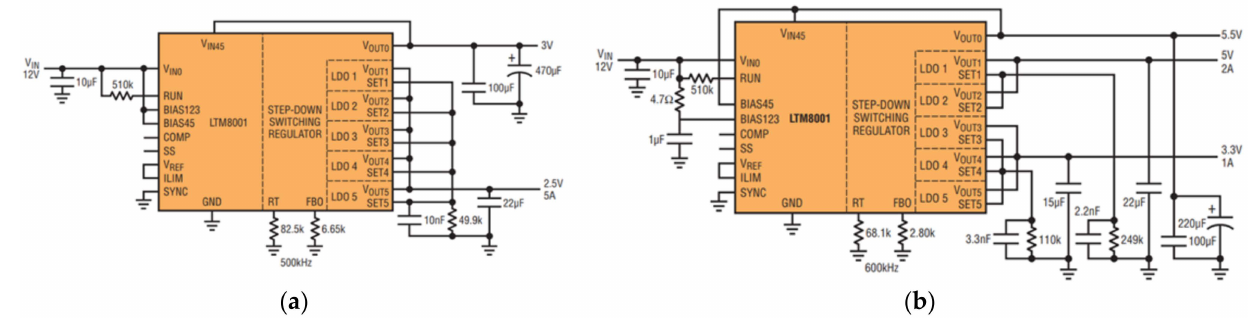
Figure 10. LTM8001 operated as a ( a ) single output [68]; and ( b ) dual outputs